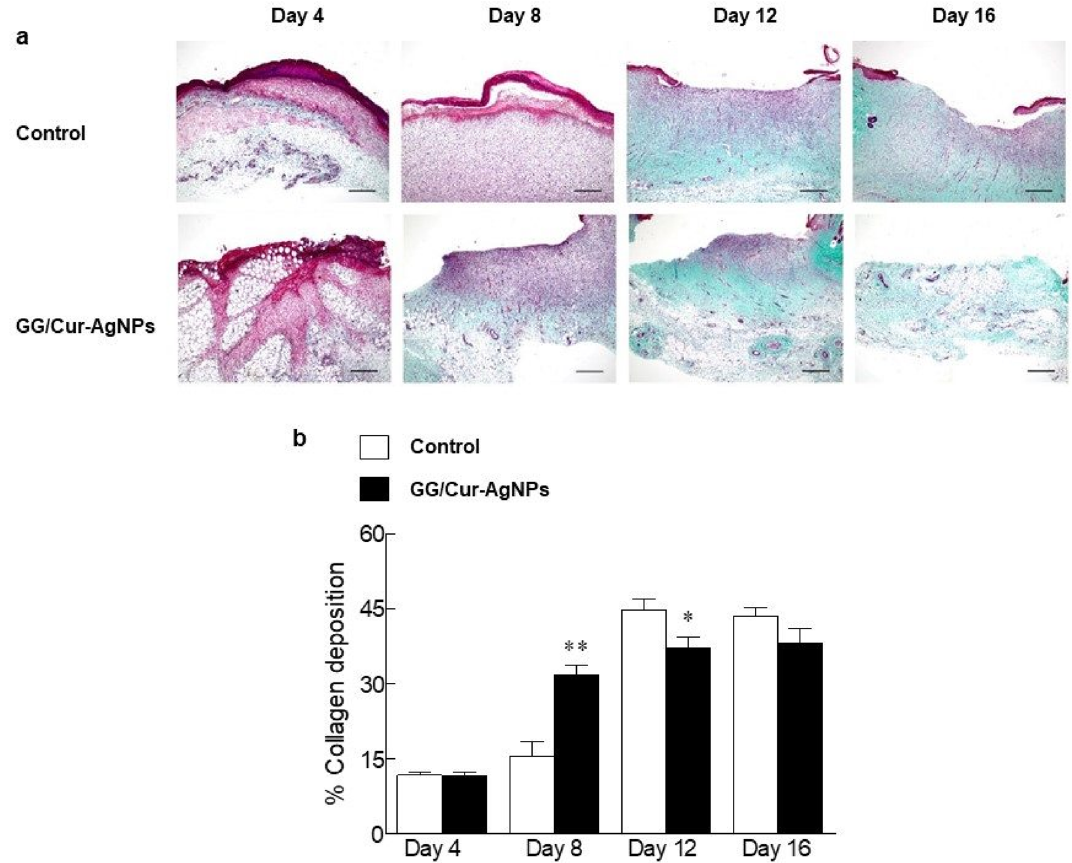
Figure 7. Histopathology of rat skin wounds on day 4, 8, 12 and 16 of the wound incisions stained with Masson’s trichrome. ( a ) Micrographs of sections of wound incision rat skin treated with commercial antibacterial gel (top) and with GG/Cur-AgNPs (bottom). Collagen is indicated by the blue-green colour. ( b ) The percentage of collagen deposition (area of blue-green colour) was measured in 10 high-power field (HPF) (400 × magnification). Data were expressed as mean ± SEM ( n = 3/time point). * P < 0.05 and ** P < 0.01 compared to the control on the day of experiments. Scale bar = 40